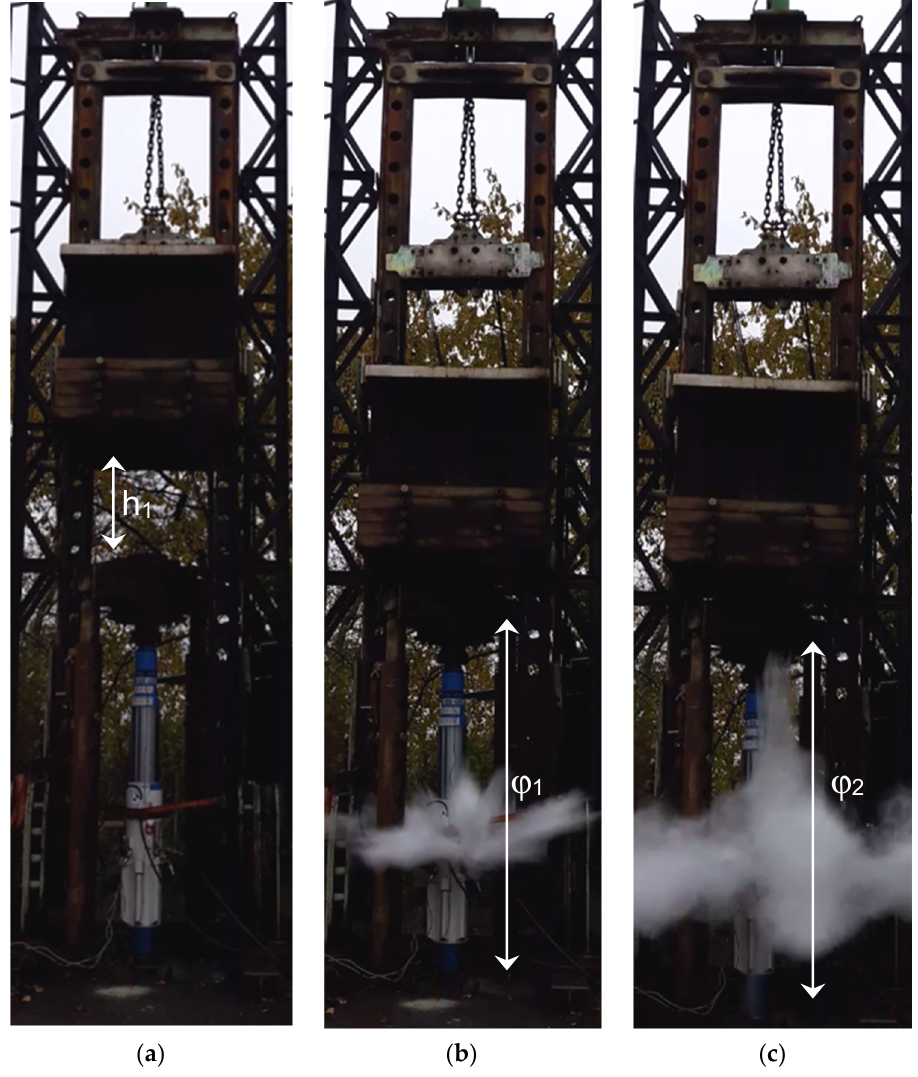
Figure 4. Testing of leg including safety valve ( a ) drop height h 1 = 0.9 m; ( b ) first chute ϕ 1 under dynamic load; ( c ) second slide φ 2 of the leg for final pressure build-up.